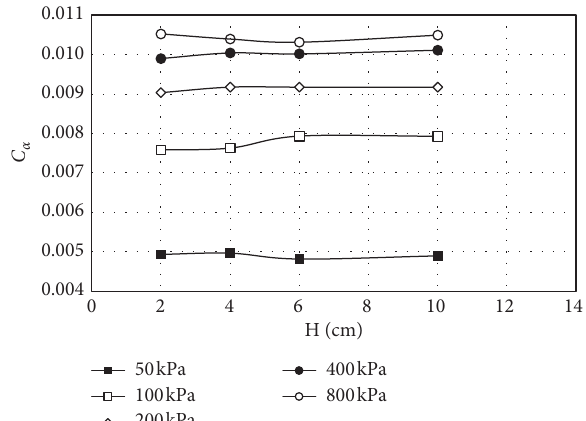
Figure 11: The relationship between the secondary consolidation coefficient and the thickness of soil samples under different loading